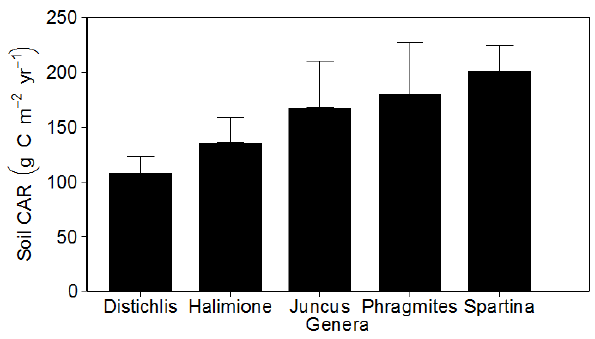
Figure 2. Comparison of CAR among halophyte genera from data in the collated references. A non-parametric post hoc pairwise test was run following Kruskal–Wallis rank sum test to test which gen- era are different from the others. Spartina marshes have signifi- cantly higher CAR but there are no significant differences in CAR among the other four groups (Kruskal–Wallis test, P > 0 . 05). Table 2. Reported area of salt